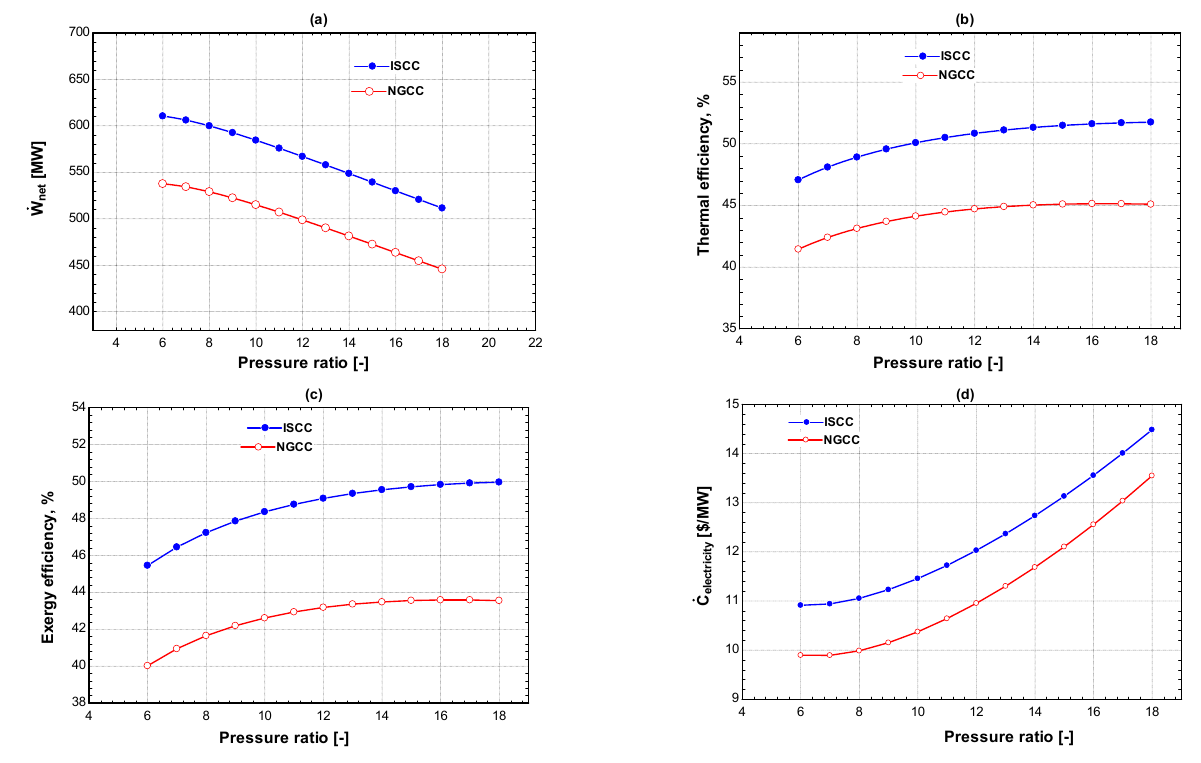
Figure 3. The effect of the pressure ratio on the overall performance and cost of both systems: ( a ) the total produced power, ( b ) thermal efficiency, ( c ) exergy efficiency, and ( d ) total rate of production costs.